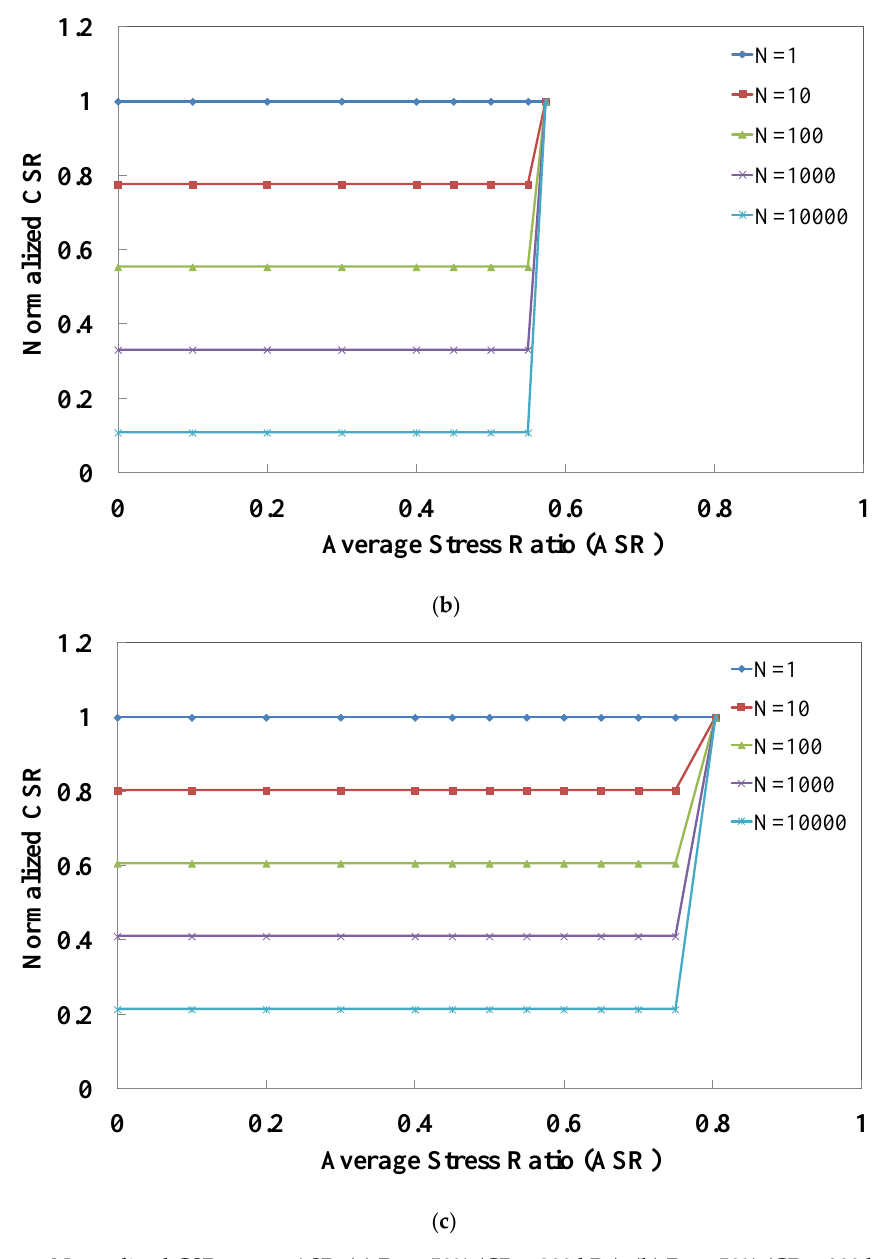
Figure 14. Normalized CSR versus ASR: ( a ) Dr = 50% (CP = 200 kPa); ( b ) Dr = 50% (CP = 300 kPa); ( c ) Dr = 85% (CP = 200 kPa).